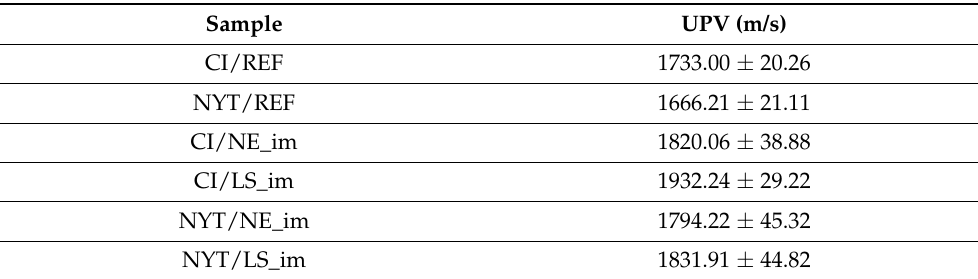
Table 6. Ultrasonic pulse velocity (UPV) for CI and NYT samples before and after consolidating treatments by full